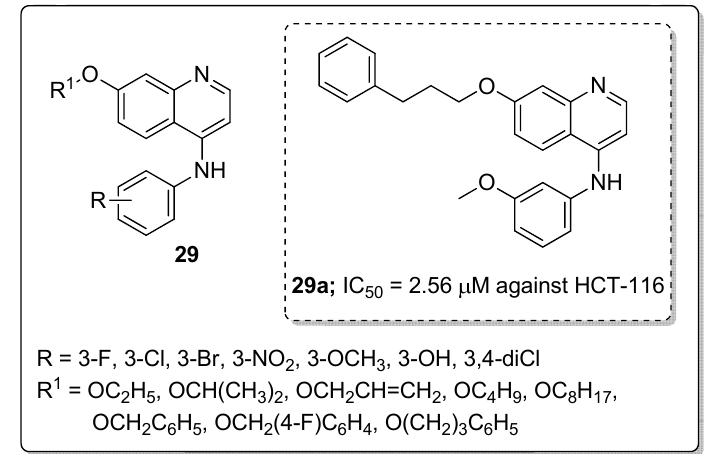
Figure 34. Antiproliferative activity of the most active quinoline conjugate 29a .